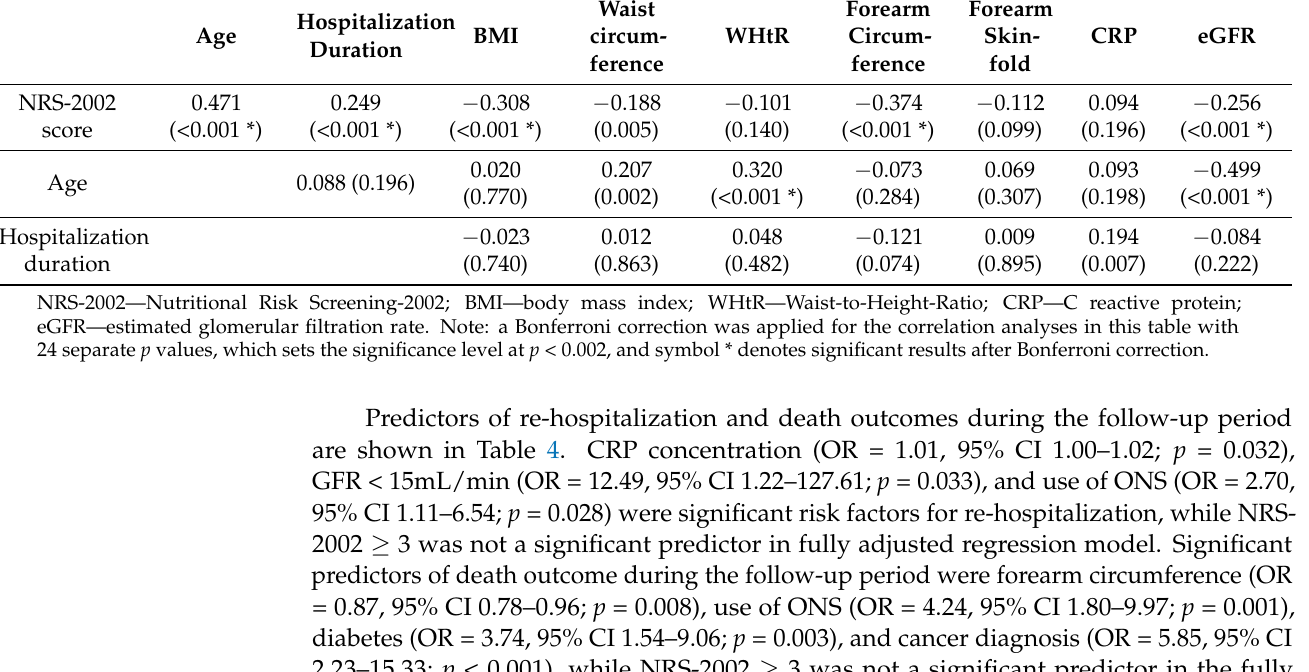
Table 3. Correlation between NRS-2002 score and anthropometric indicators and other important clinical parameters, n = 218 (data are presented as Spearman’s rho ( p value)).